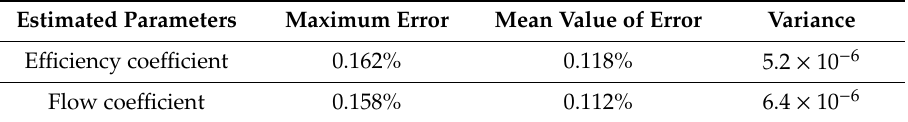
Table 1. Erroranalysisundertheconditionofslowdegradationofperformancebasedontraditionalmethod. Table 1. Error analysis under the condition of slow degradation of performance based on traditional method.